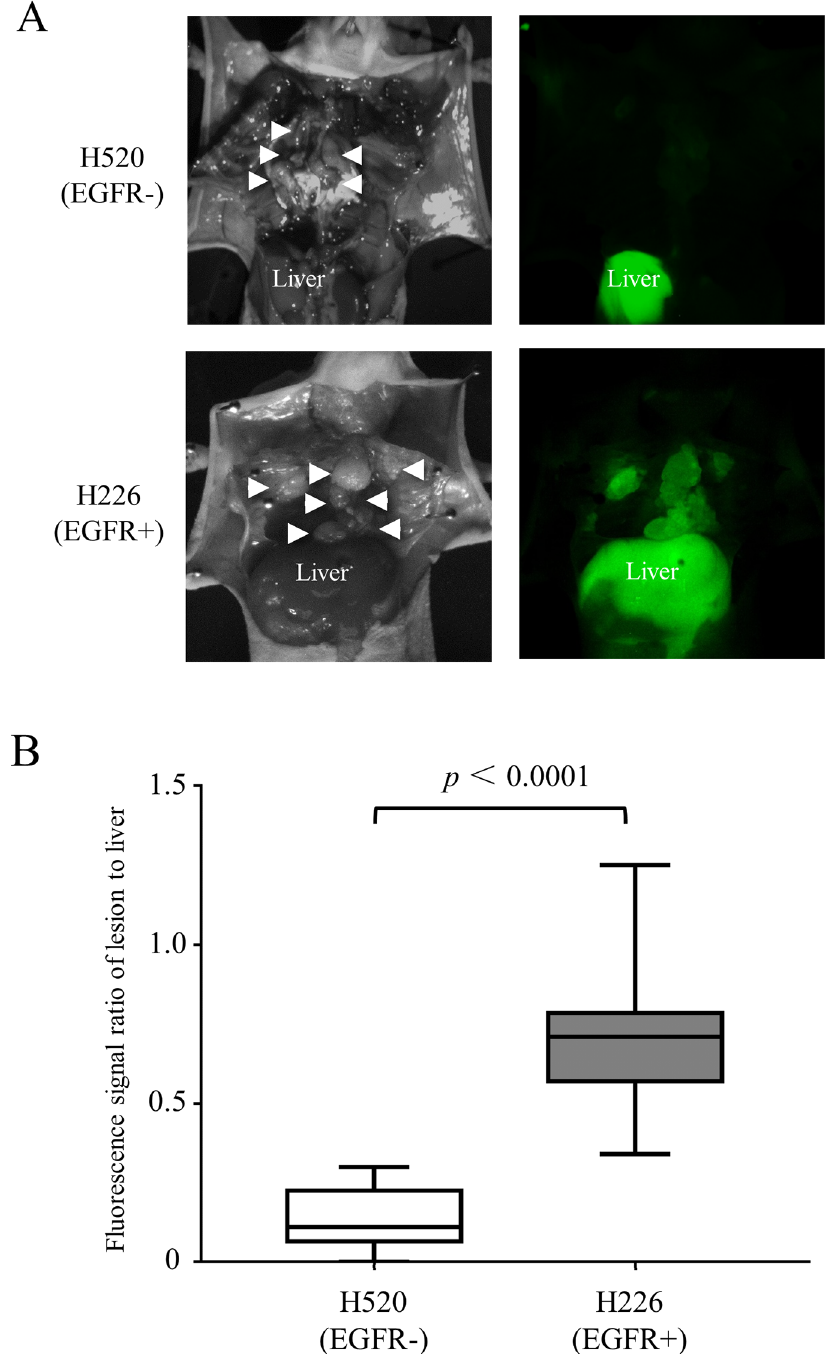
Fig 5. In vivo EGFR targeted imaging. (A) In vivo fluorescence images of an EGFR- (upper) and EGFR+ (lower) tumor bearing mouse injected with 50 μg of Pan-ICG. EGFR+ lymph node metastases (white arrow heads) showed high fluorescence signals while no signals from EGFR- ones were seen. On both images, the liver showed high signals with non-specific accumulations. (B) Comparison of the fluorescence signal ratio of lesion to liver between EGFR+ and—lymph node metastases 48 hours after injection of 50 μg Pan-ICG. The signal ratio was significantly higher in EGFR+ lymph node metastases than in EGFR- ones ( p < 0.05).